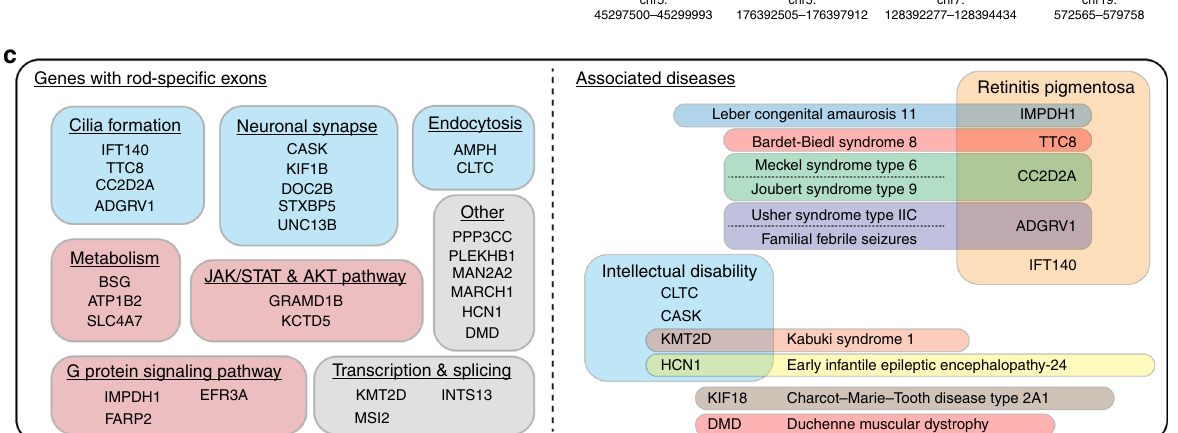
supporting a mechanism of direct interaction (Supplementary Fig. 10). UAG motif frequencies were compared to a baseline of all protein coding exons (<400 bp) in the GENCODE v28 basic gene annotation and exon examples are visualized in Fig.